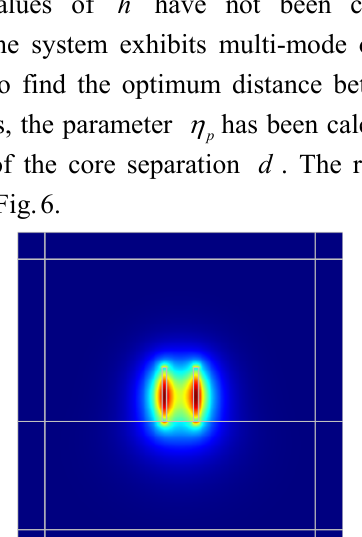
0.175 w  , and  h , env env